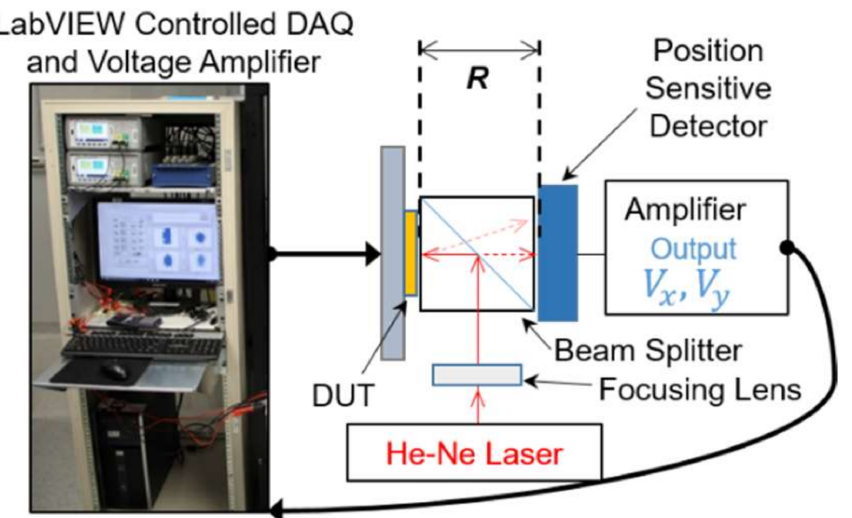
Figure 3. The optical setup used to characterize the tip/tilt angles of both devices, which allows one to measure the output range, step, and frequency response. The setup used a laser and a position sensitive detector (PSD) to track the tilting angle of the device, and the signals are controlled/read through LabVIEW DAQ, where R is the distance between the device under test (DUT) and the detector. The schematic is from a top view